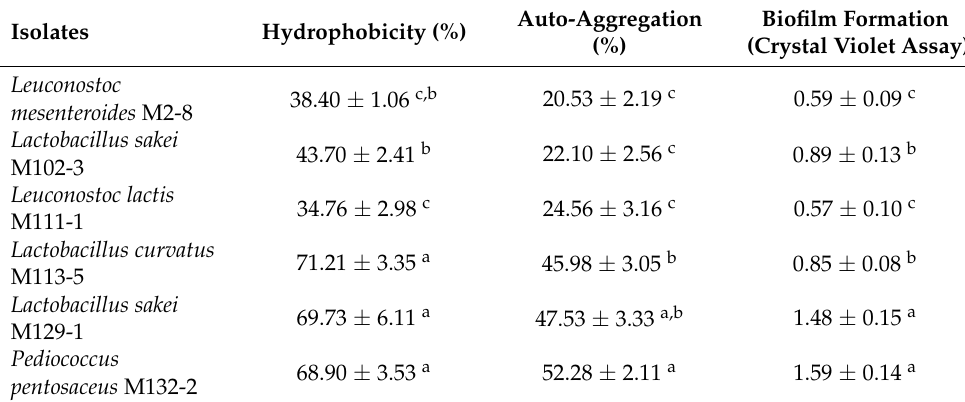
Table 2. Hydrophobicity, auto-aggregation, biofilm formation, and survival rate of each LAB isolate in acidic pH or bile